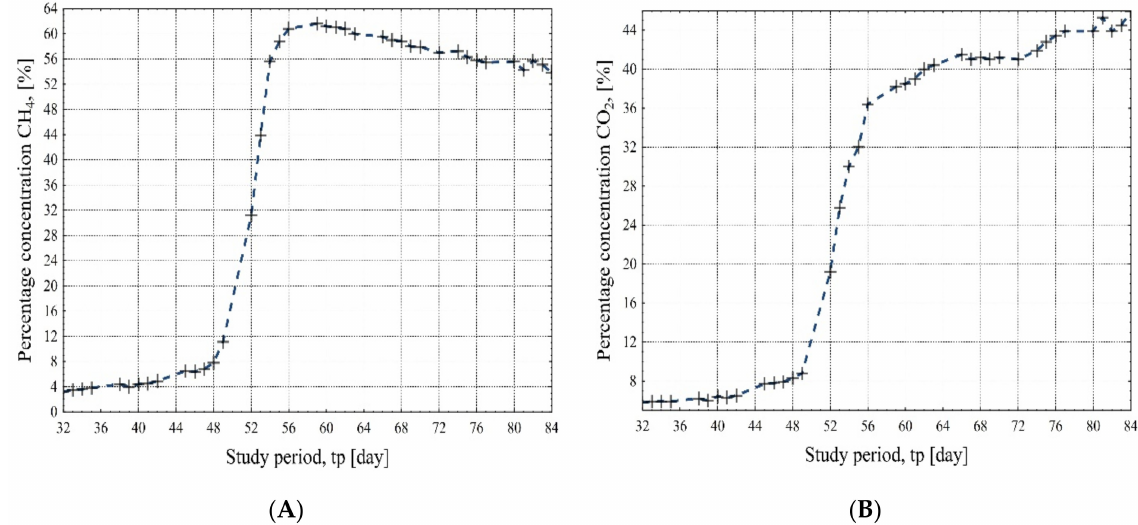
Figure 3. Changes in the percentage concentration of methane (CH 4 ) (%) ( A ) and carbon dioxide (CO 2 ) (%) ( B ) depending on the duration of biogas installation start-up tp (day).